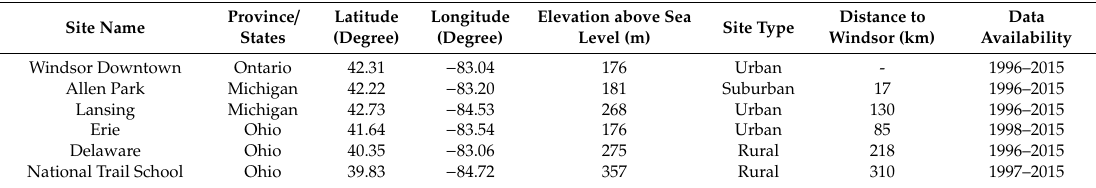
Table 1. Parameters of selected monitoring sites. Data source: Windsor station from MECP [27], five US sites from USEPA [28].